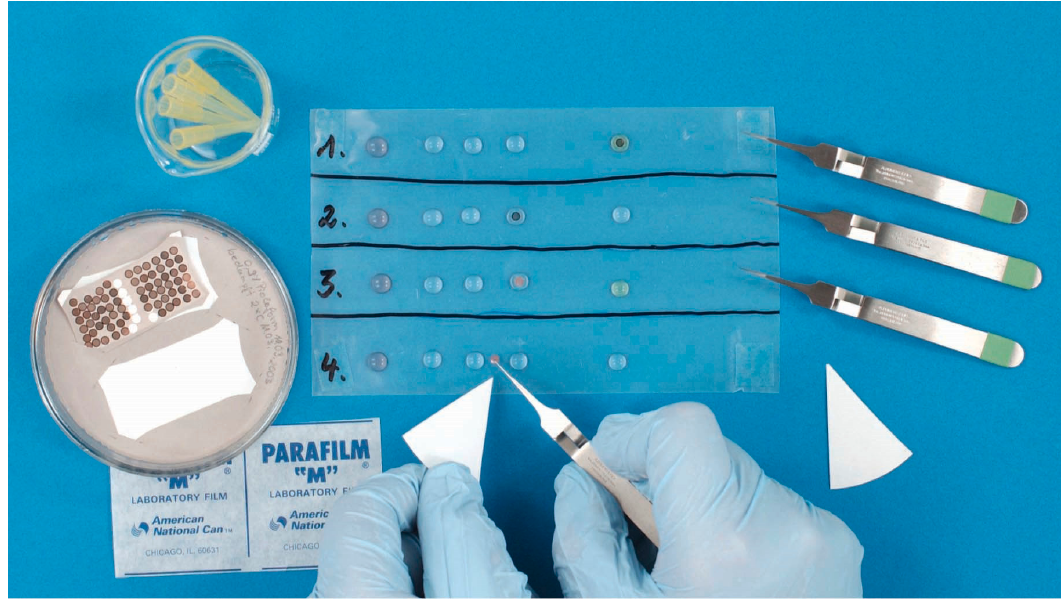
Figure 14. NS, the most rapid technique in diagnostic virology. It is done using a non-wetting surface, such as a sheet of Parafilm TM , and comprises the following steps: adsorption, washing and staining. A hydrophilic EM support grid is placed on a droplet of the diagnostic suspension (left) and after 30 s of adsorption is transferred quickly onto a series of droplets of distilled water to remove interfering salts, and then onto a droplet of “stain”. The “stains” used are electron-dense solutions: 0.5 to 2.0 percent of a heavy metal salt, such as PTA, routinely buffered to pH 7.2 (may be used between pH 5 to pH 9), UAc, unbuffered at a pH around 4.2, or other stains can be used. During a short, 5–10 s staining step, the stain does not react with the chemical moieties of the biologicals on the grid, i.e., there is no “positive staining” effect as there is in thin section-TEM. This rapid process results in “negative contrast”, as the transparent biological structures of the sample, after drying, are closely surrounded by the electron-dense stain. Reprinted from [45] with the kind permission of Springer Nature.